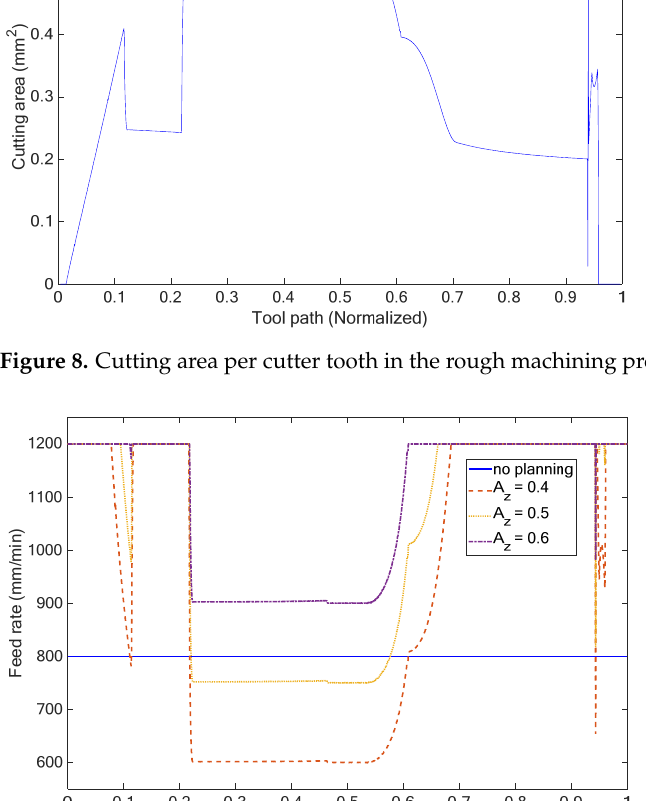
Table 3. Experimental results without and with adaptive feed rate planning.